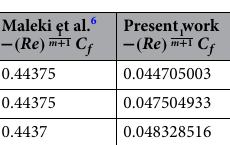
Table 3. Validation of skin friction coefficient with published work for Pr